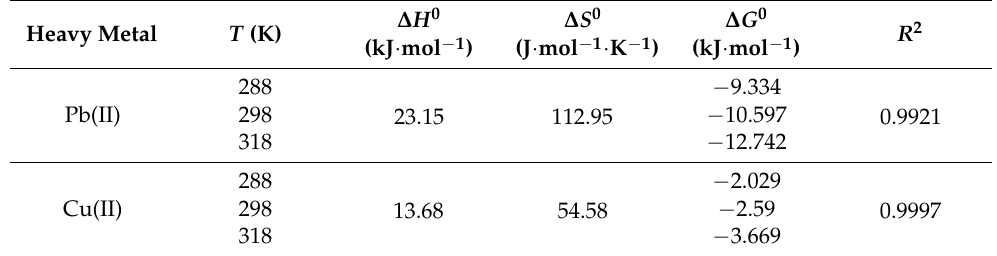
Table 10. The thermodynamics parameters of the adsorption process at different